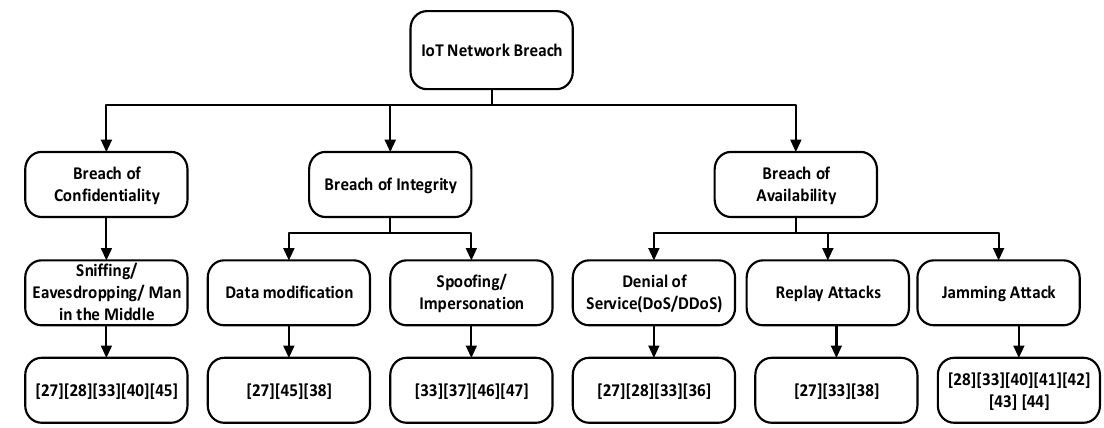
Figure 4. Attack tree for LPWAN and Internet of things (IoT) networks. Table 2. Possible attacks and impacts on LPWAN communication layer [28,33,40].